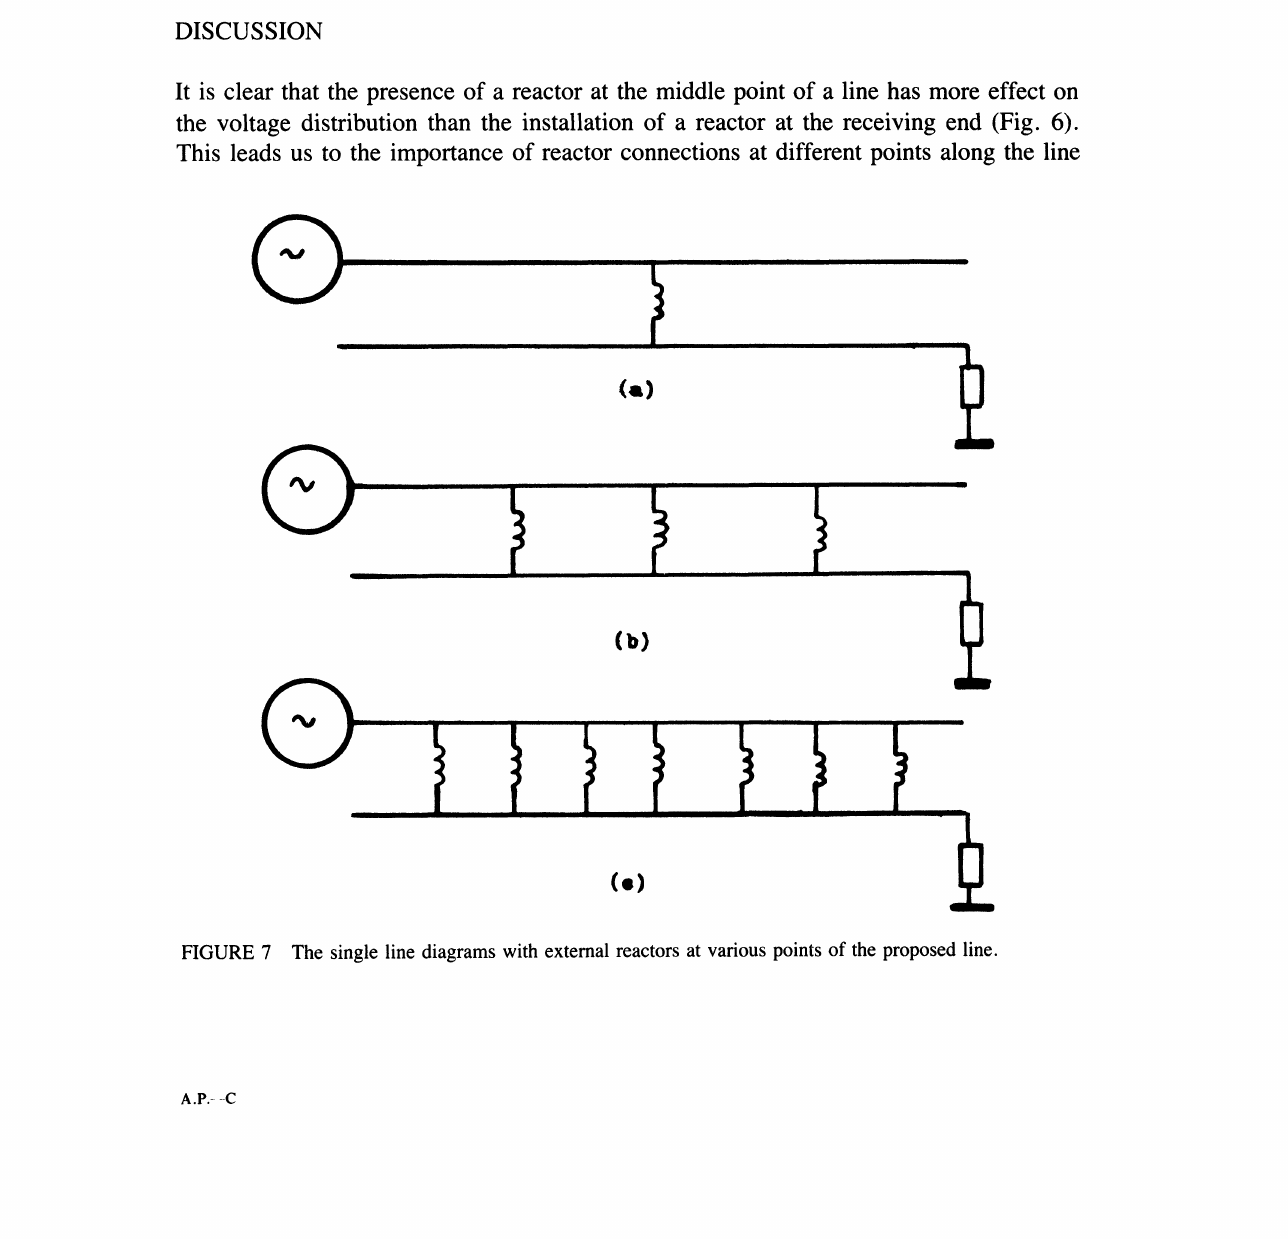
FIGURE 7 The single line diagrams with external reactors at various points of the proposed